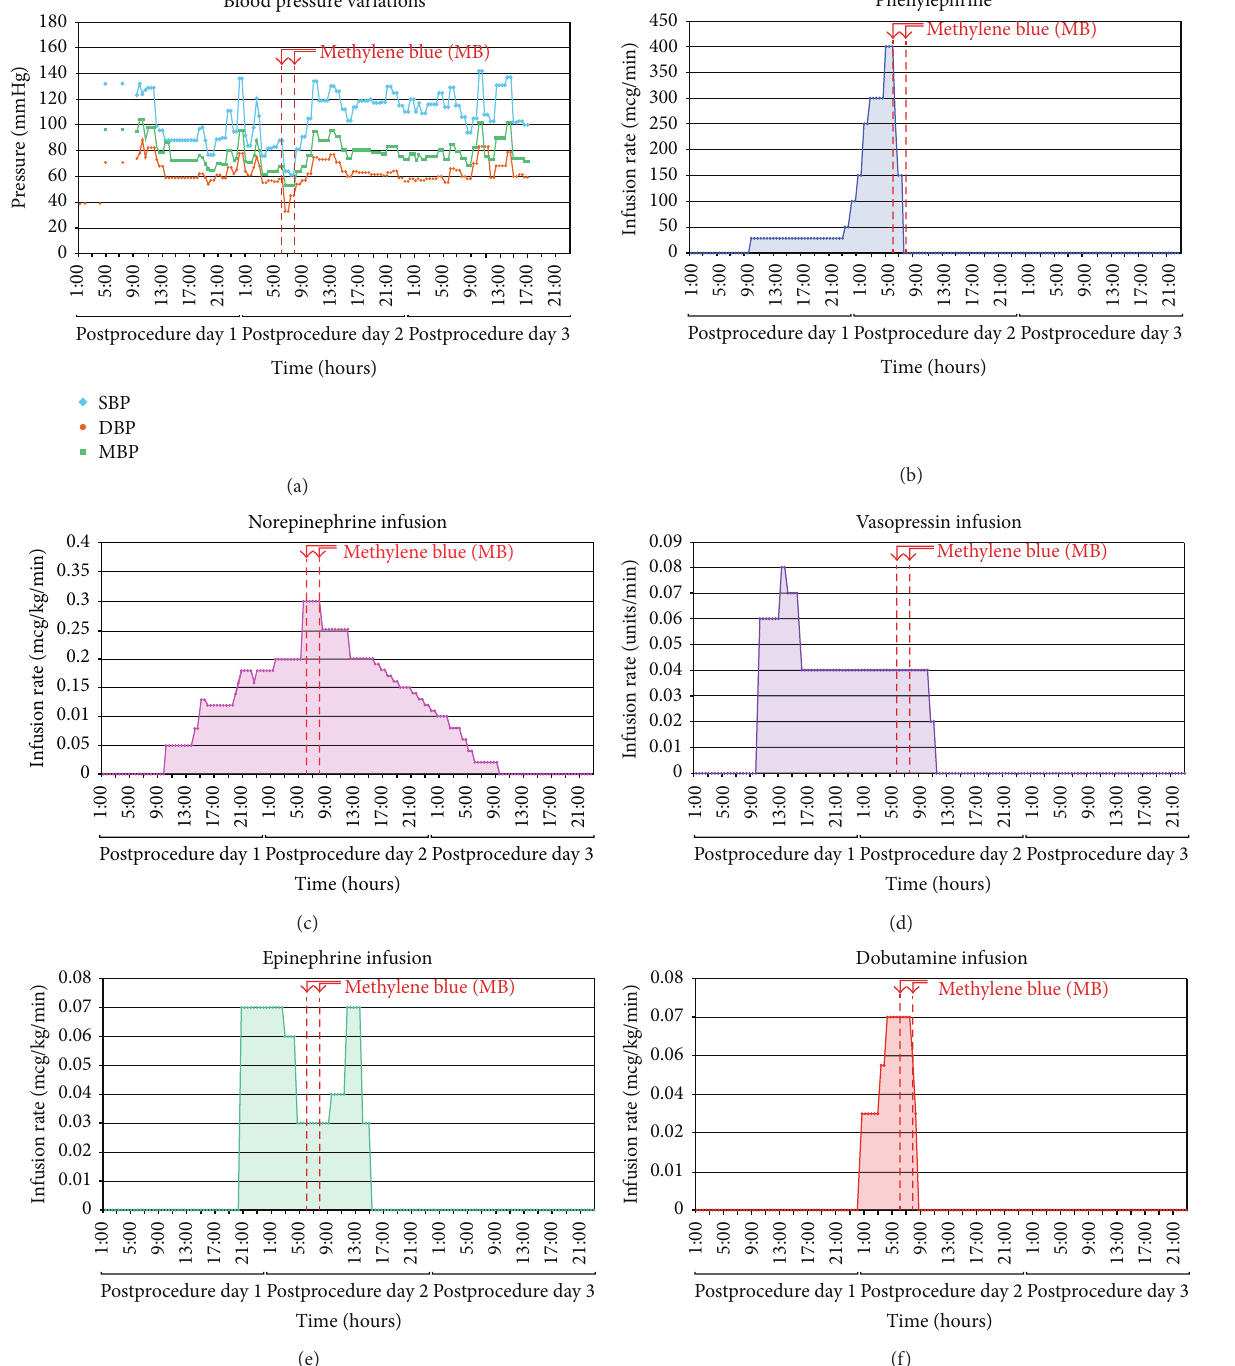
Figure 1: (a) Graph showing blood pressure variations across time period; blood pressure (Blue—SBP; brown—DBP; green—MAP) in Y axis and time elapsed in hours from postprocedure day 1 to post procedure 3 in X axis. (b) Graph showing phenylephrine infusion with infusion rate (mcg/min) in Y axis and time elapsed in hours from postprocedure day 1 to postprocedure 3 in X axis. (c) Graph showing norepinephrine infusion with infusion rate (mcg/kg/min) in Y axis and time elapsed in hours from postprocedure day 1 to postprocedure 3 in X axis. (d) Graph showing vasopressin infusion with infusion rate (Units/min) in Y axis and time elapsed in hours from postprocedure day 1 to postprocedure 3 in X axis. (e) Graph showing epinephrine infusion with infusion rate (mcg/kg/min) in Y axis and time elapsed in hours from postprocedure day 1 to postprocedure 3 in X axis. (f) Graph showing dobutamine infusion with infusion rate (mcg/kg/min) in Y axis and time elapsed in hours from postprocedure day 1 to postprocedure 3 in X axis. Double dash vertical lines across graphs (a, b, c, d, e and f) depict the period of methylene blue (MB)